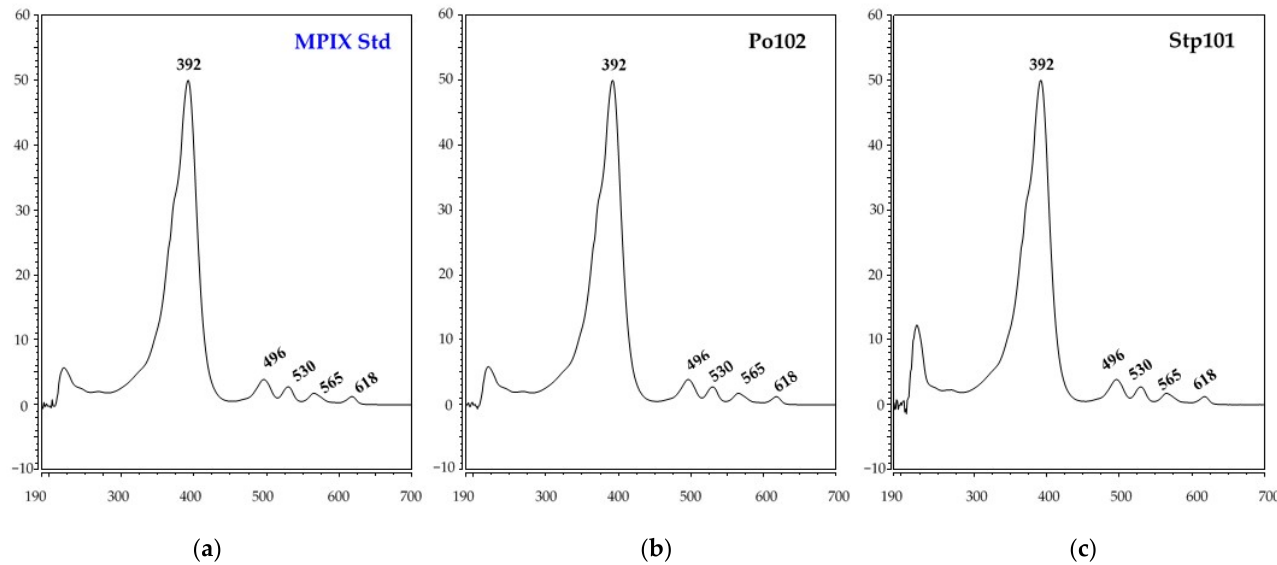
Figure 6. Comparison of absorption spectra of porphyrin standard, MPIX, and chromatographic peaks of the extracts exhibited at R t about 45 min: ( a ) MPIX standard; ( b ) G. arilaitensis Po102 at R t 45.37 min; ( c ) G. arilaitensis Stp101at R t 45.37 min.